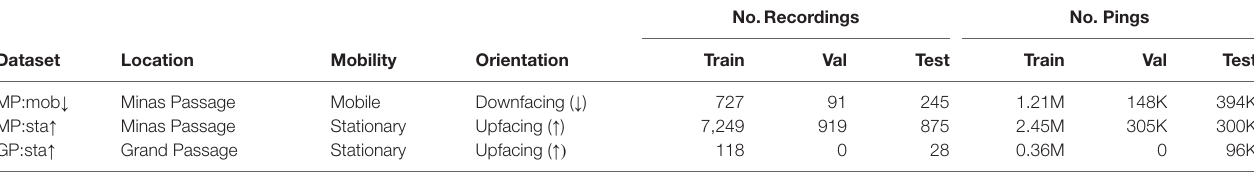
TABLE 1 | Summary of datasets used in this study: their recording locations, mobility, and recording